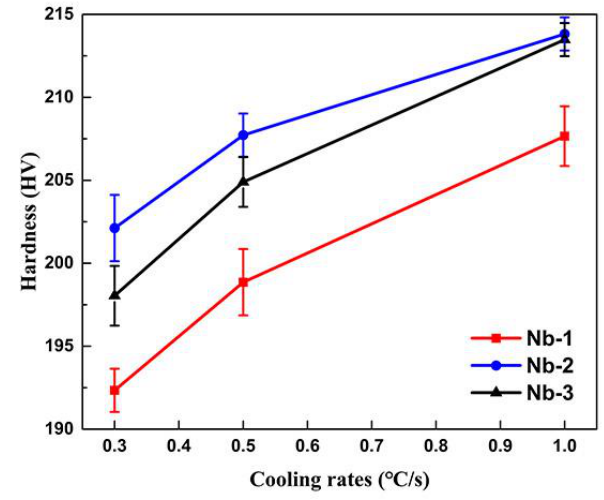
Figure 12. Dependence of hardness on cooling rate of the tested steels.